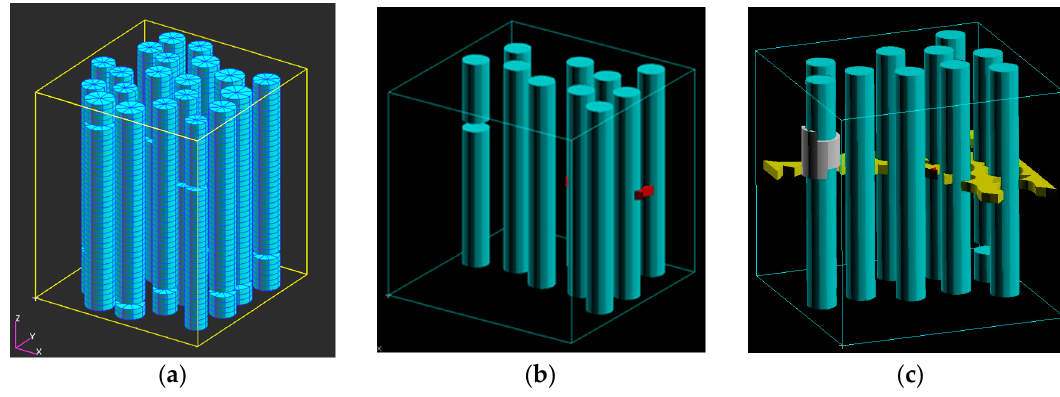
Figure 3. 3D FE micromechanical model: ( a ) example of a 3D unit cell; ( b ) competition of damage modes: one failed fiber and a few microcracks in the matrix (red); and ( c ) two fibers have failed, the interface crack is formed in the vicinity of a fiber crack and the matrix crack is formed ( ε = 0.015) (reprinted from [29] with kind permission from Elsevier).